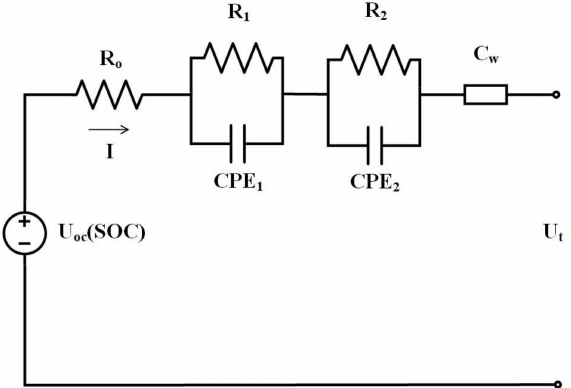
Figure 16. 2-RC fractional order model with a Warburg element [43].